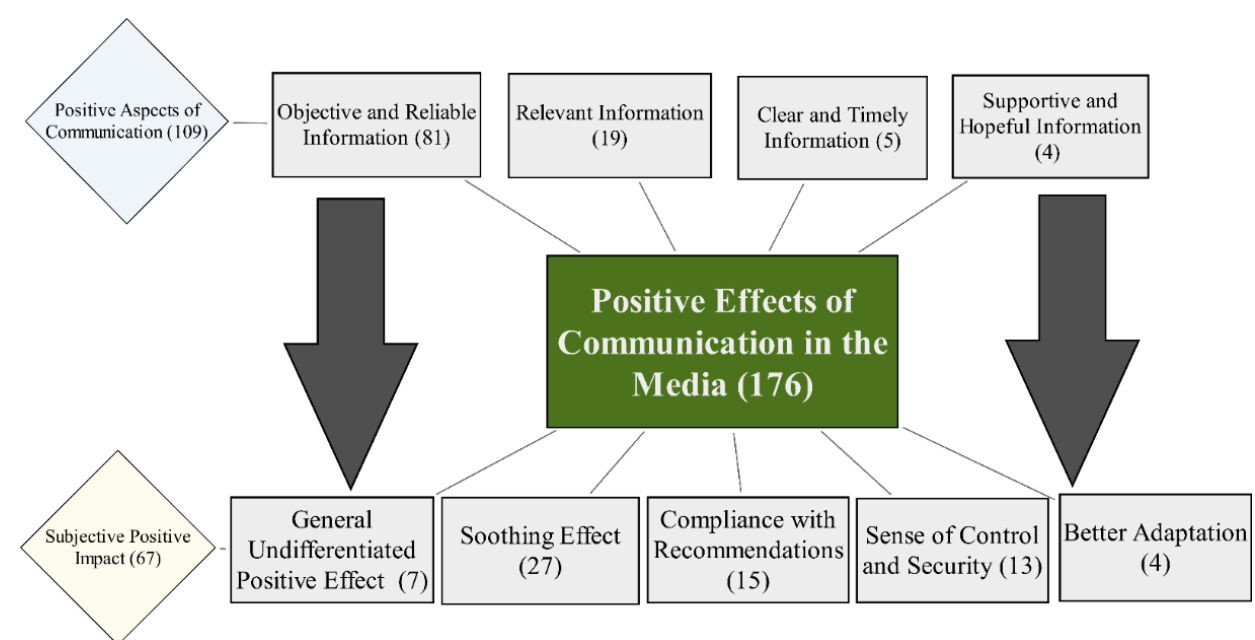
Figure 2. Thematic Model: “Positive Effects of Communication in the Media” .